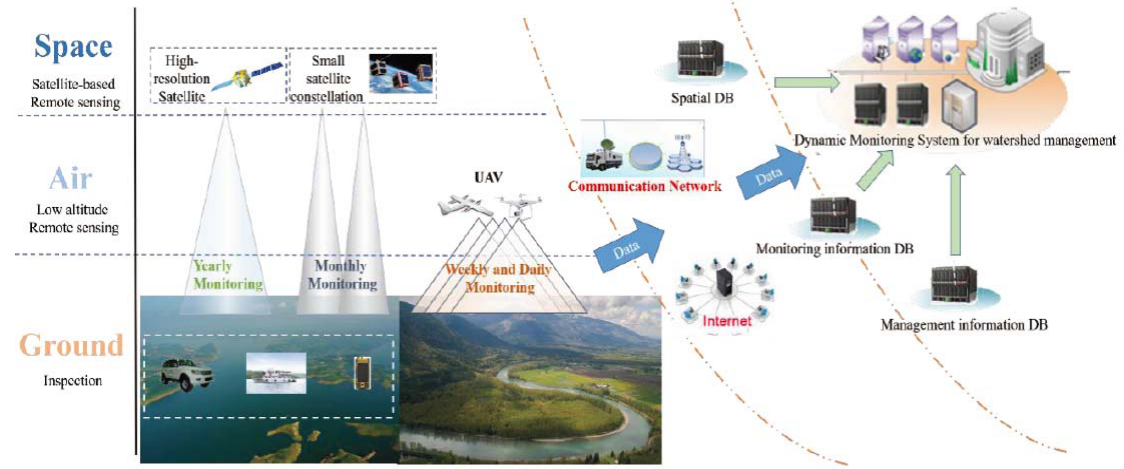
Figure 1. Dynamic monitoring system for watershed management based on space-air-ground